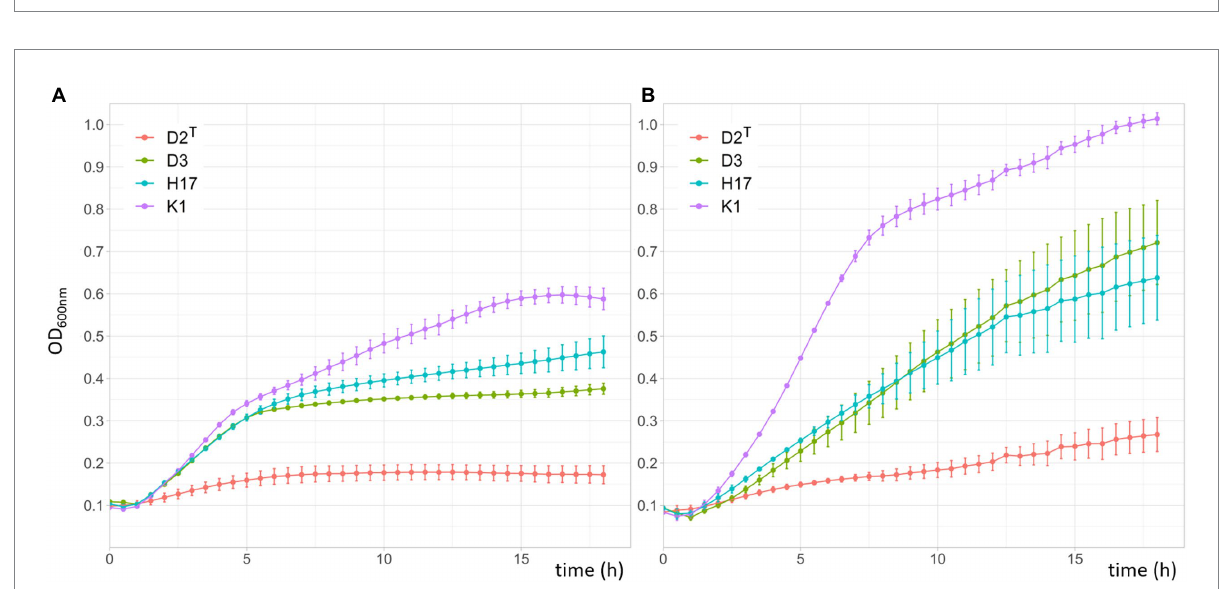
FIGURE 4 Growth of S. capitis strains in double concentrated R2A (A) and TSB (B) for 18h in a 96-well-plate at 37°C. Measurements were taken in a microplate reader. Initial OD 600nm was adjusted to 0.1. Presented OD 600nm values are the average of three biological replicates performed in triplicates each. Error bars represent the calculated standard